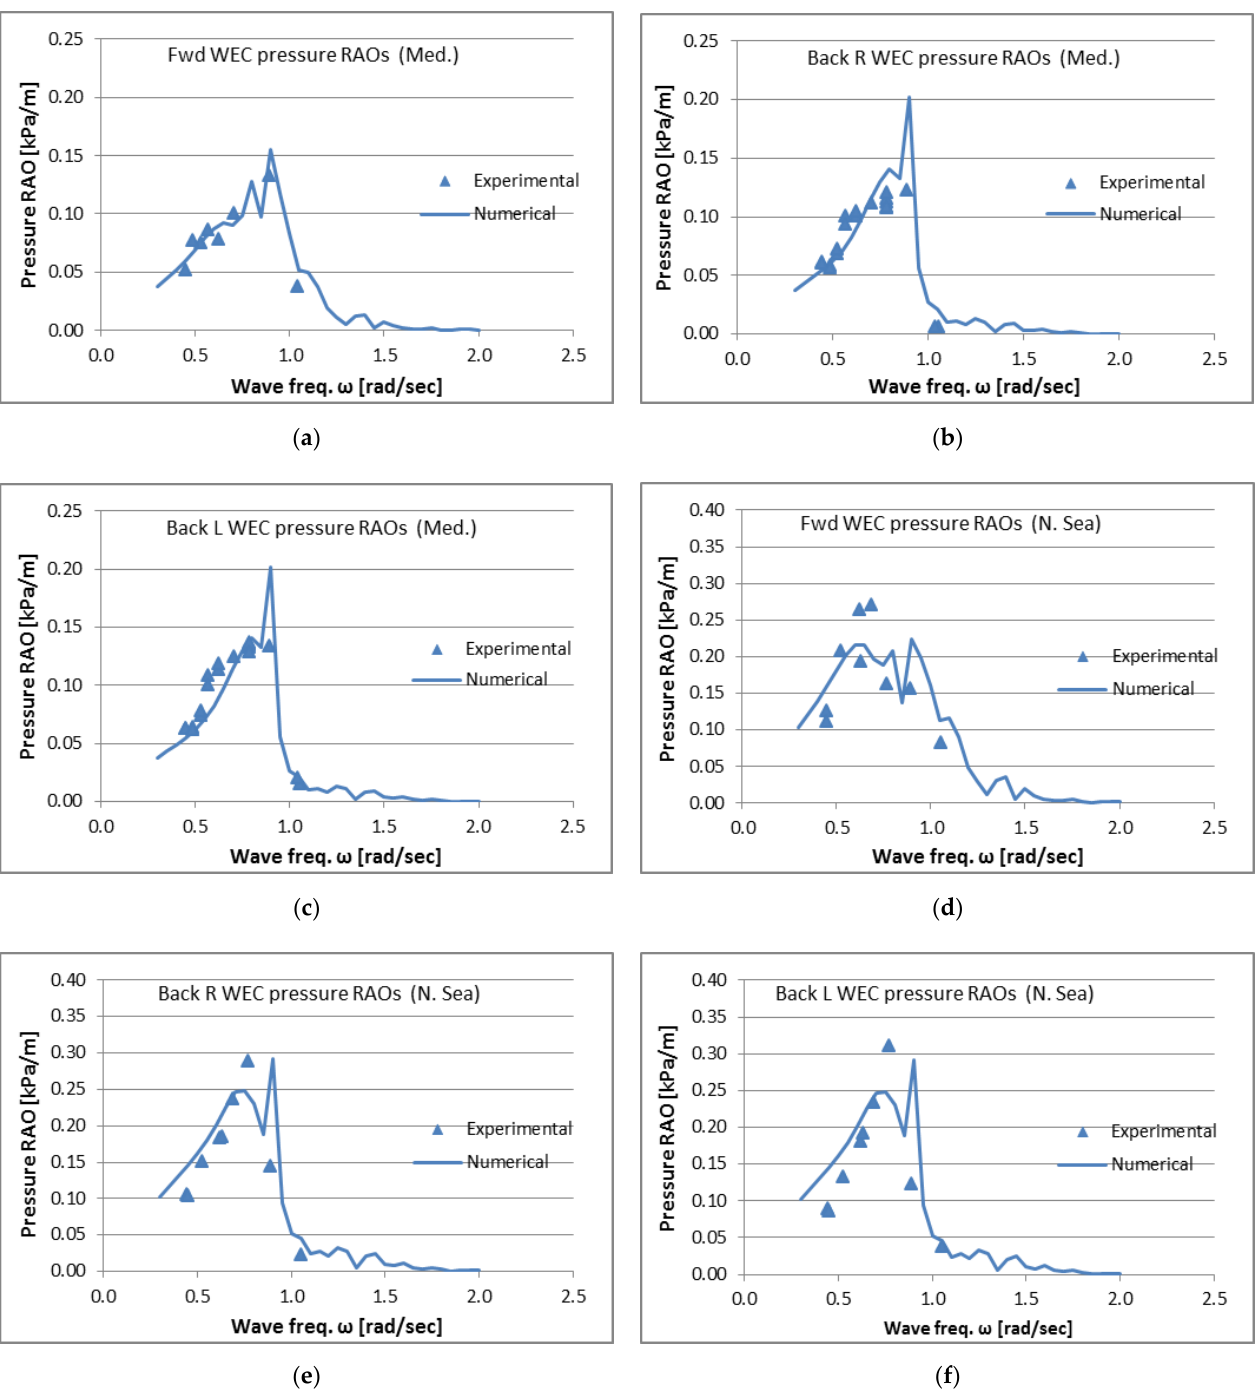
Figure 12. REFOS air pressure comparisons: ( a ) forward OWC for the Mediterranean Sea location; ( b ) backward left OWC for the Mediterranean Sea location; ( c ) backward right OWC for the Mediterranean Sea location; ( d ) forward OWC for the North Sea location; ( e ) backward left OWC for the North Sea location; ( f ) backward right OWC for the North Sea location.